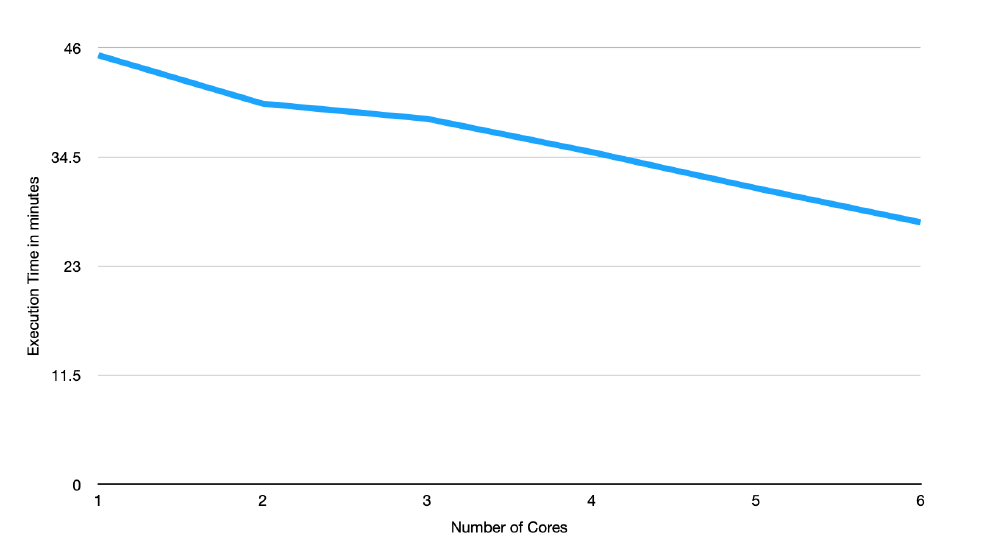
Figure 9. Multi-core